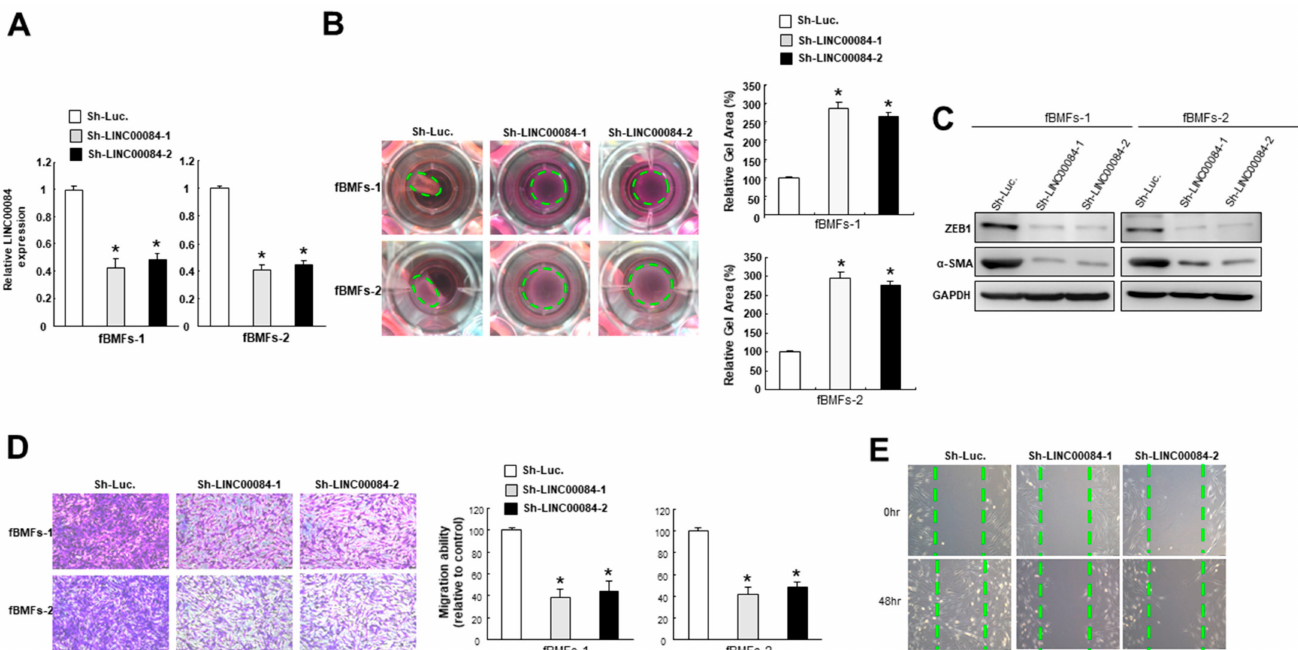
Figure 3. Suppression of LINC00084 attenuates the myofibroblasts properties. ( A ) The knockdown efficiency of sh- LINC00084 in two patient-derived fBMFs; collagen gel contractility ( B ), the expression level of ZEB1 and α -SMA ( C ), transwell migration ( D ), and wound healing ( E ) abilities were examined in two fBMFs transfected with sh-Luc. or sh- LINC00084. Results are means ± SD of triplicate samples from three experiments. * p < 0.05 compared to sh-Luc.